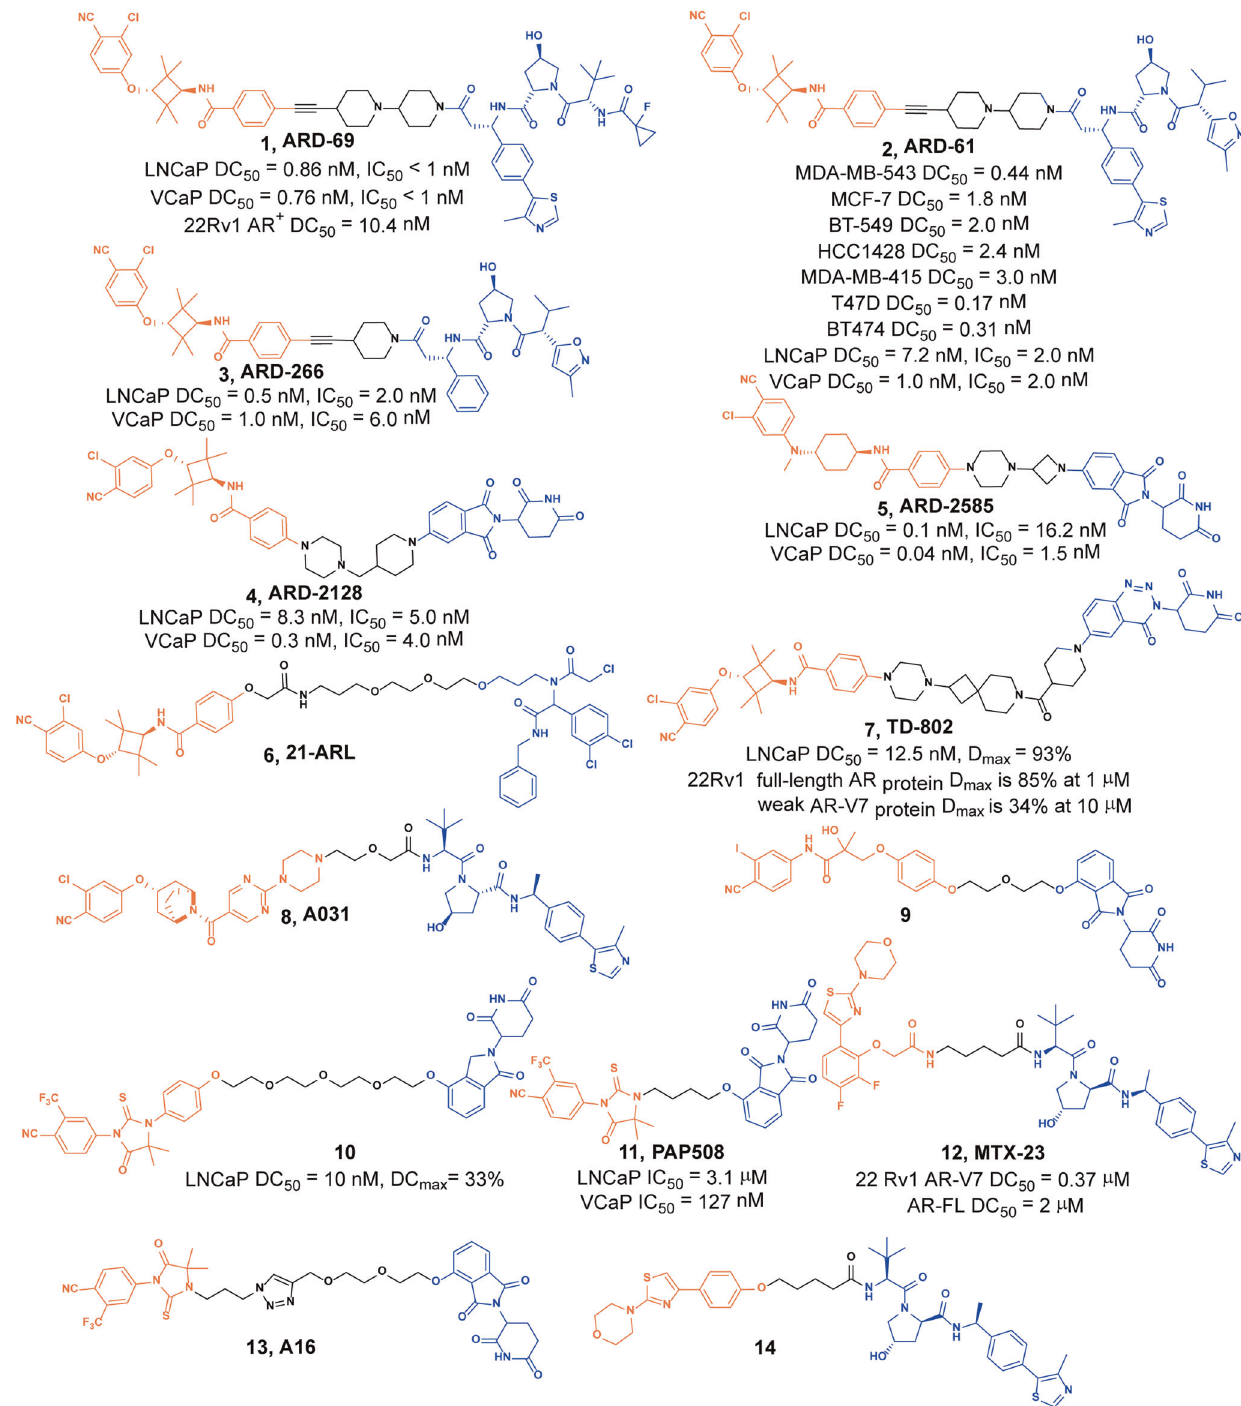
Fig. 4 The representative PROTACs targeting AR